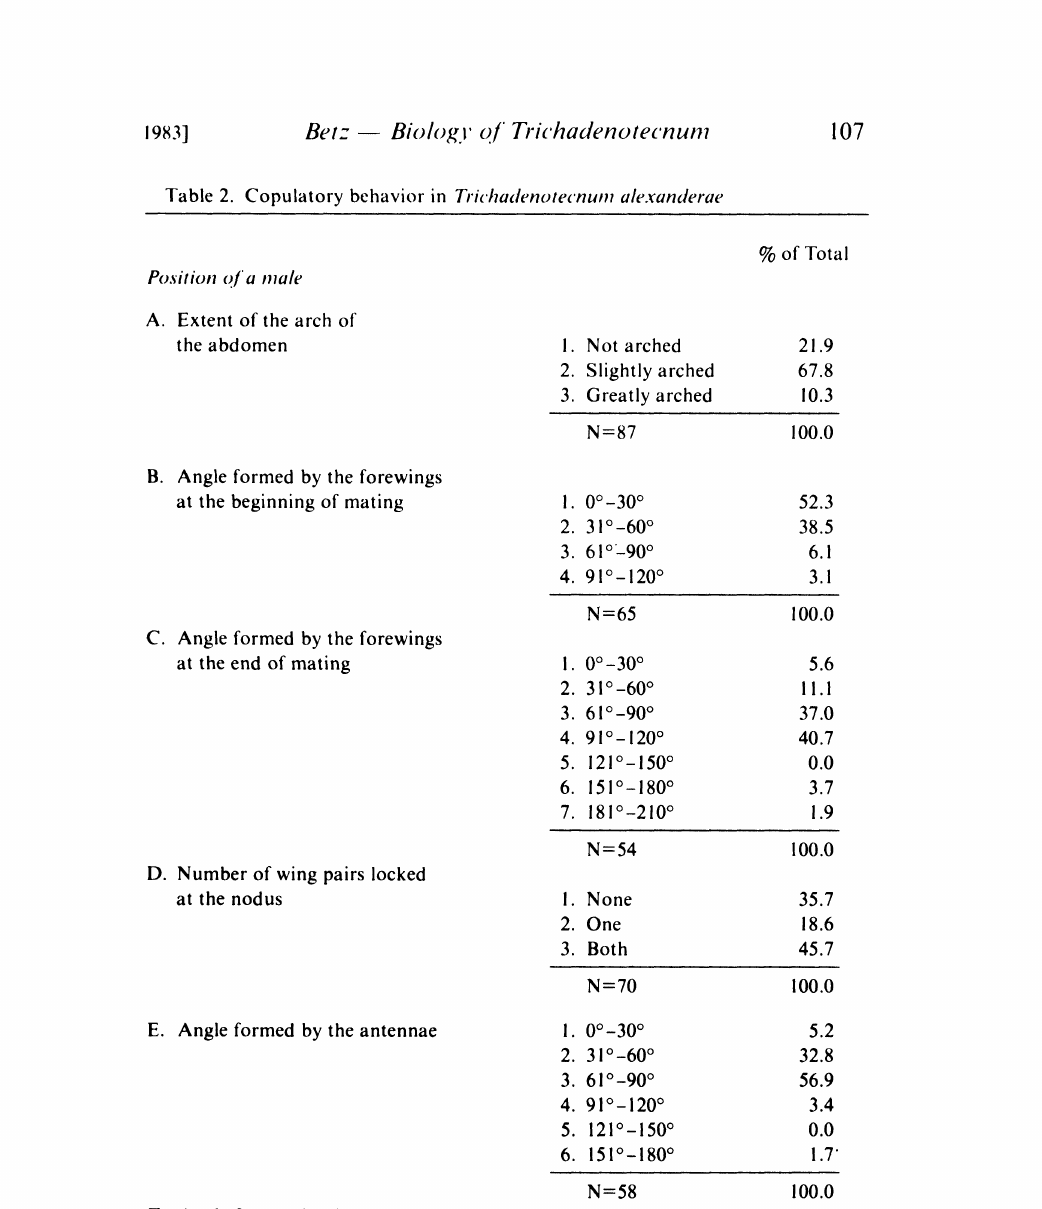
Table 2. Copulatory behavior in Trichadenotecnunt alexanderae